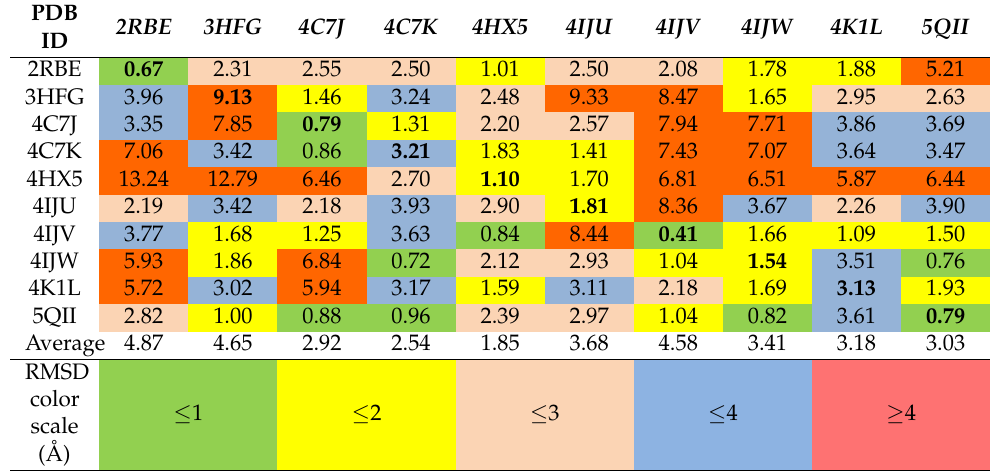
Table 7. The cross-docking results of the RMSD values of the native and non-native ligands with the lowest binding affinity scores. Columns represent the enzymes and rows represent the co-crystallized ligands.